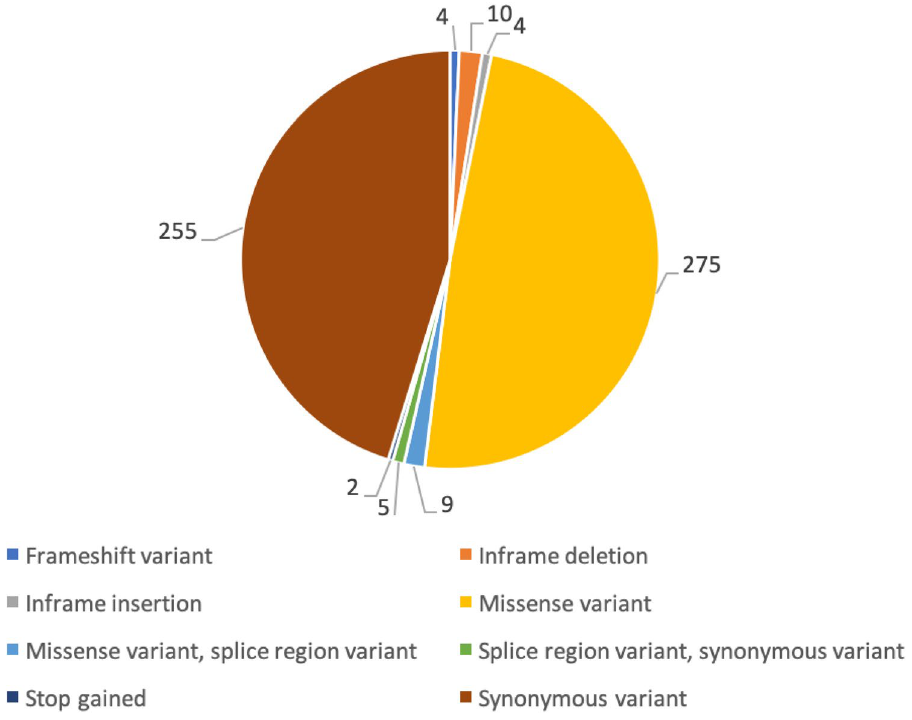
Figure 1. Mutation counts and types for RYR1 variants in SG10K pilot